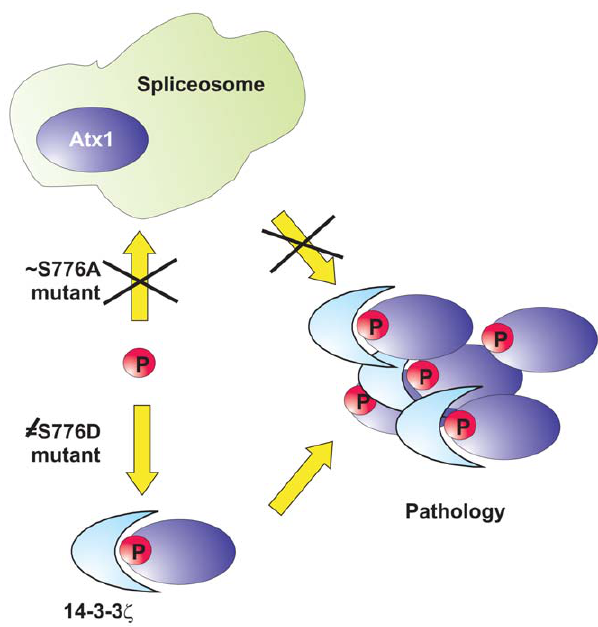
Figure 7. Schematic model of the cellular interactions formed by Atx1 and the role that phosphorylation plays in pathology. S776 phosphorylation would be at the crossing point of two different pathways. When Atx1 (blue oval) is not phosphorylated, it interacts with the spliceosome (light blue shape) and is protected from aggregation. Phosphorylated Atx1 has higher affinity to 14-3-3 proteins but is not protected against self-association. In vitro, the Ala mutant mimics correctly the properties of non-phosphorylated Atx1, whereas the Asp mutant, which has properties very different from the phosphorylated sequence, is not recognized by